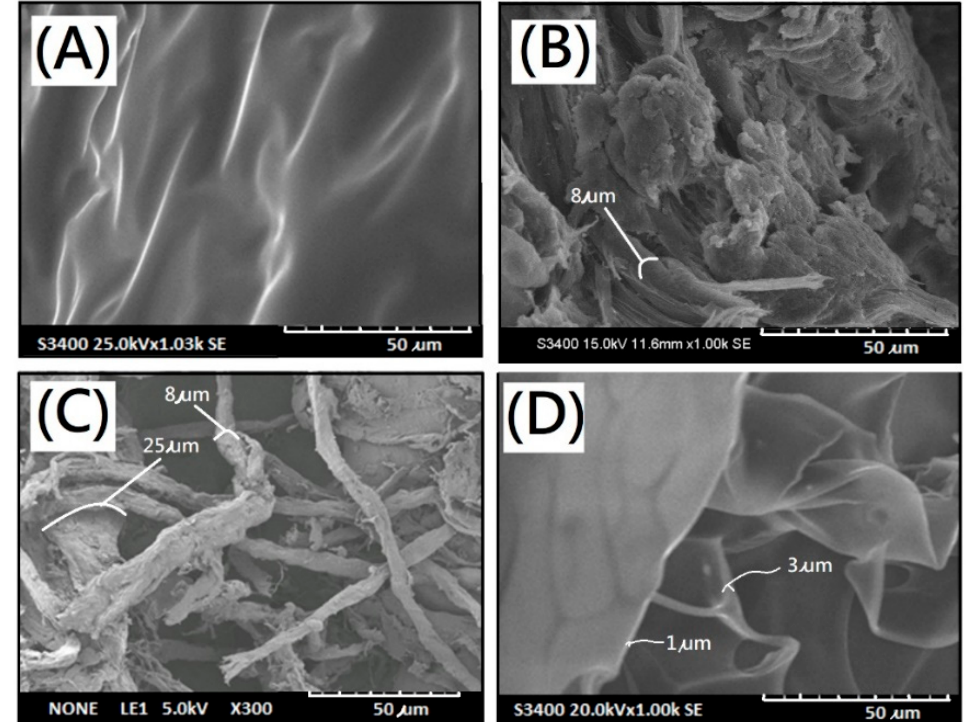
Figure 2. Scanning electron micrographs of samples of ( A ) original porcine skin, ( B ) pretreated porcine skin by ScCO 2 , ( C ) dECM powder, and ( D ) AdE0N membrane.